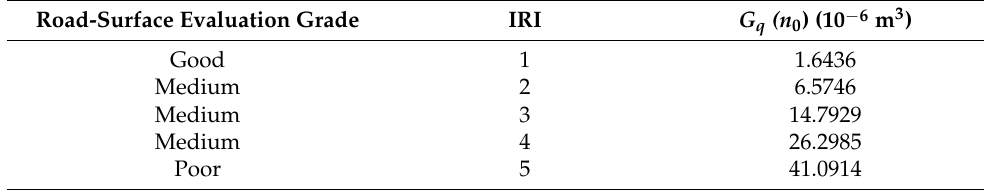
Table 2. The PSD of different IRI grades.